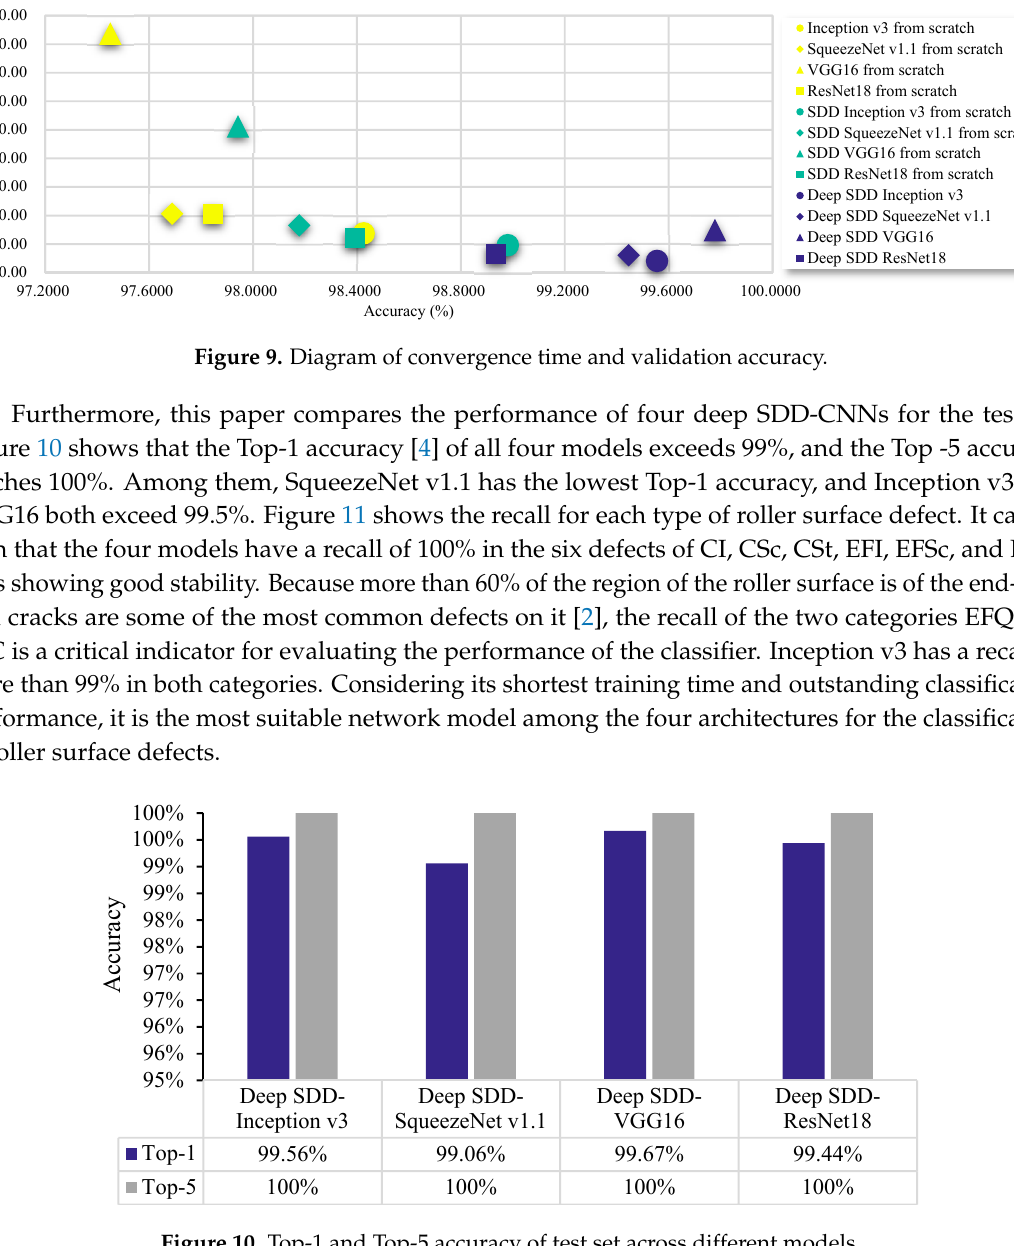
Figure 10. Top-1 and Top-5 accuracy of test set across different models.